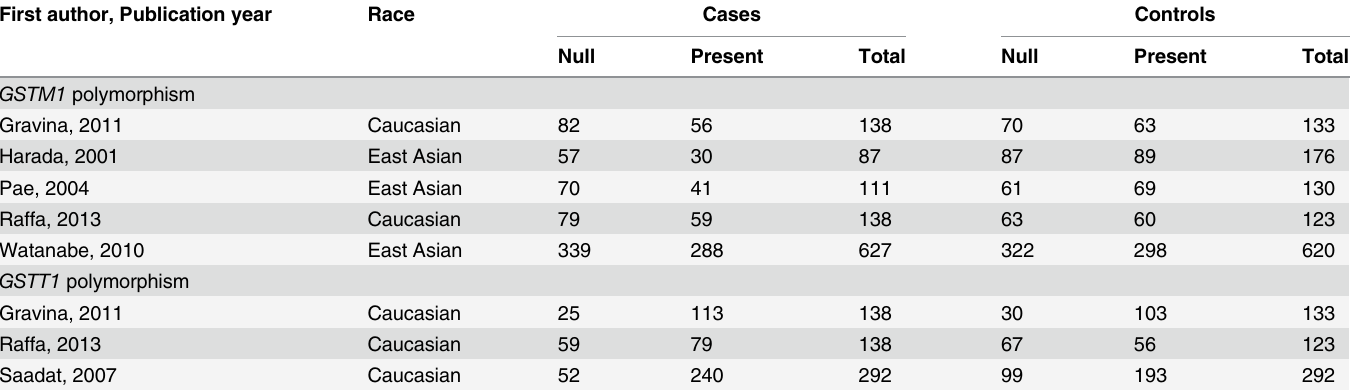
Table 2. Genotype distributions of GSTM1/T1 polymorphisms among SCZ and healthy control.